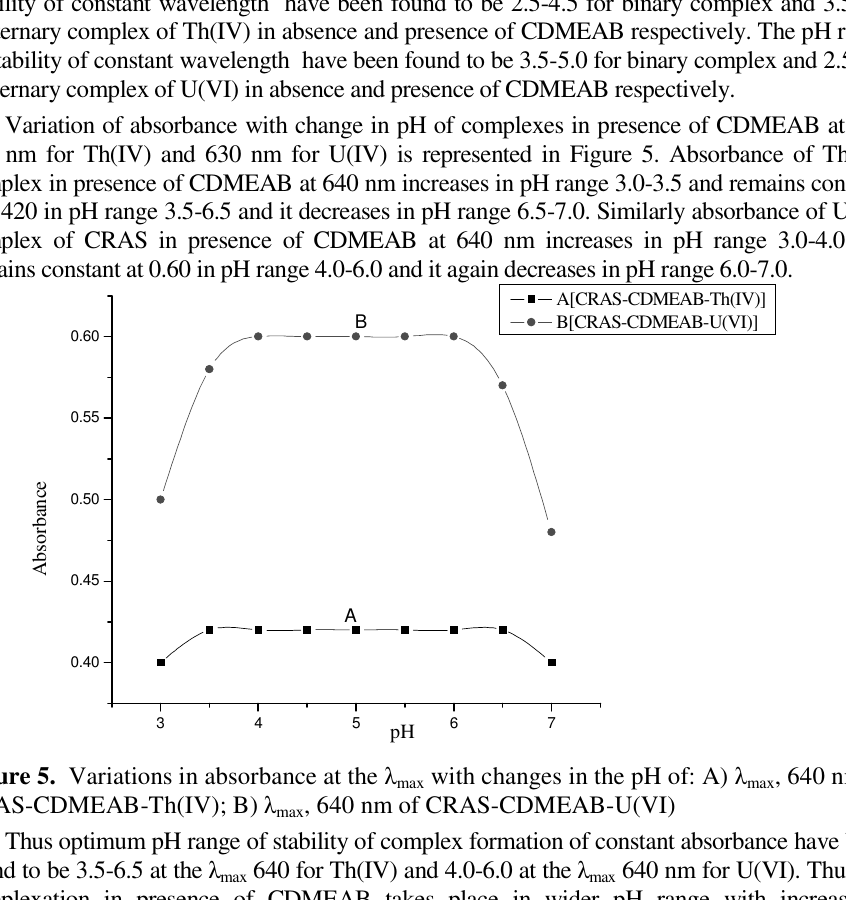
with changes in the pH of: A) λ max , 640 nm of max